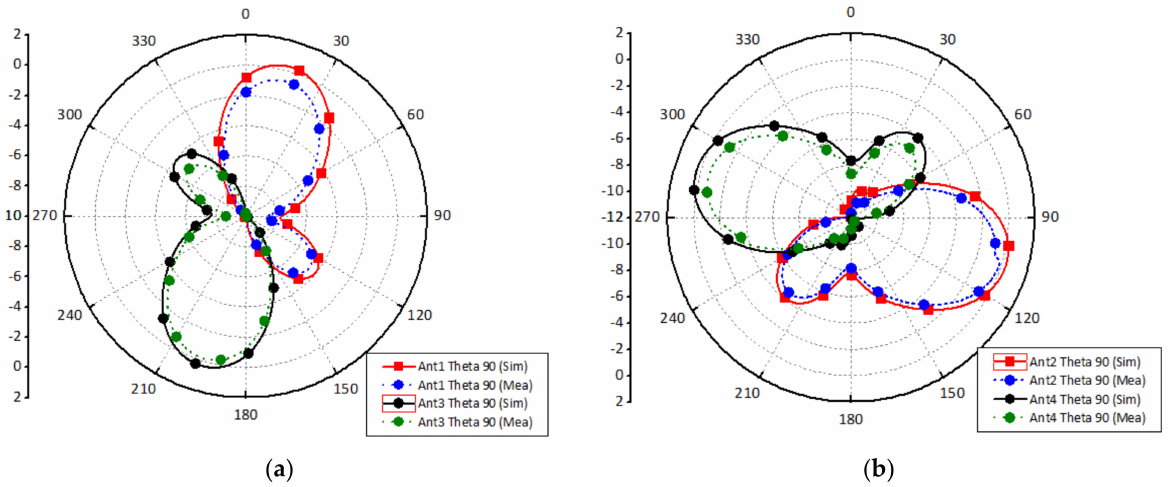
Figure 6. Radiation patterns at 4.8 GHz: ( a ) Theta 90 Ant 1, Ant 3, ( b ) Theta 90 Ant 2, Ant 4, ( c ) Phi 90 Ant 1, Ant 2, and ( d ) Phi 90 Ant 3, Ant 4.